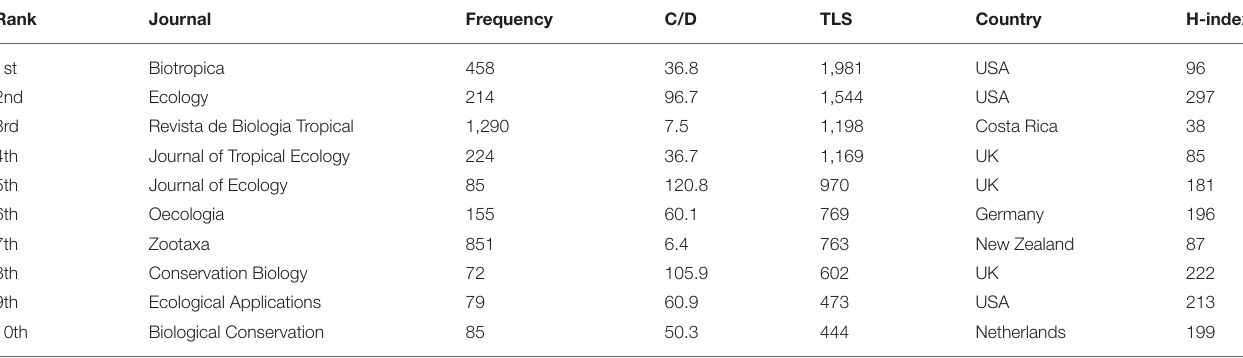
TABLE 4 | Top ten publishing journals in biodiversity topics in Central America.